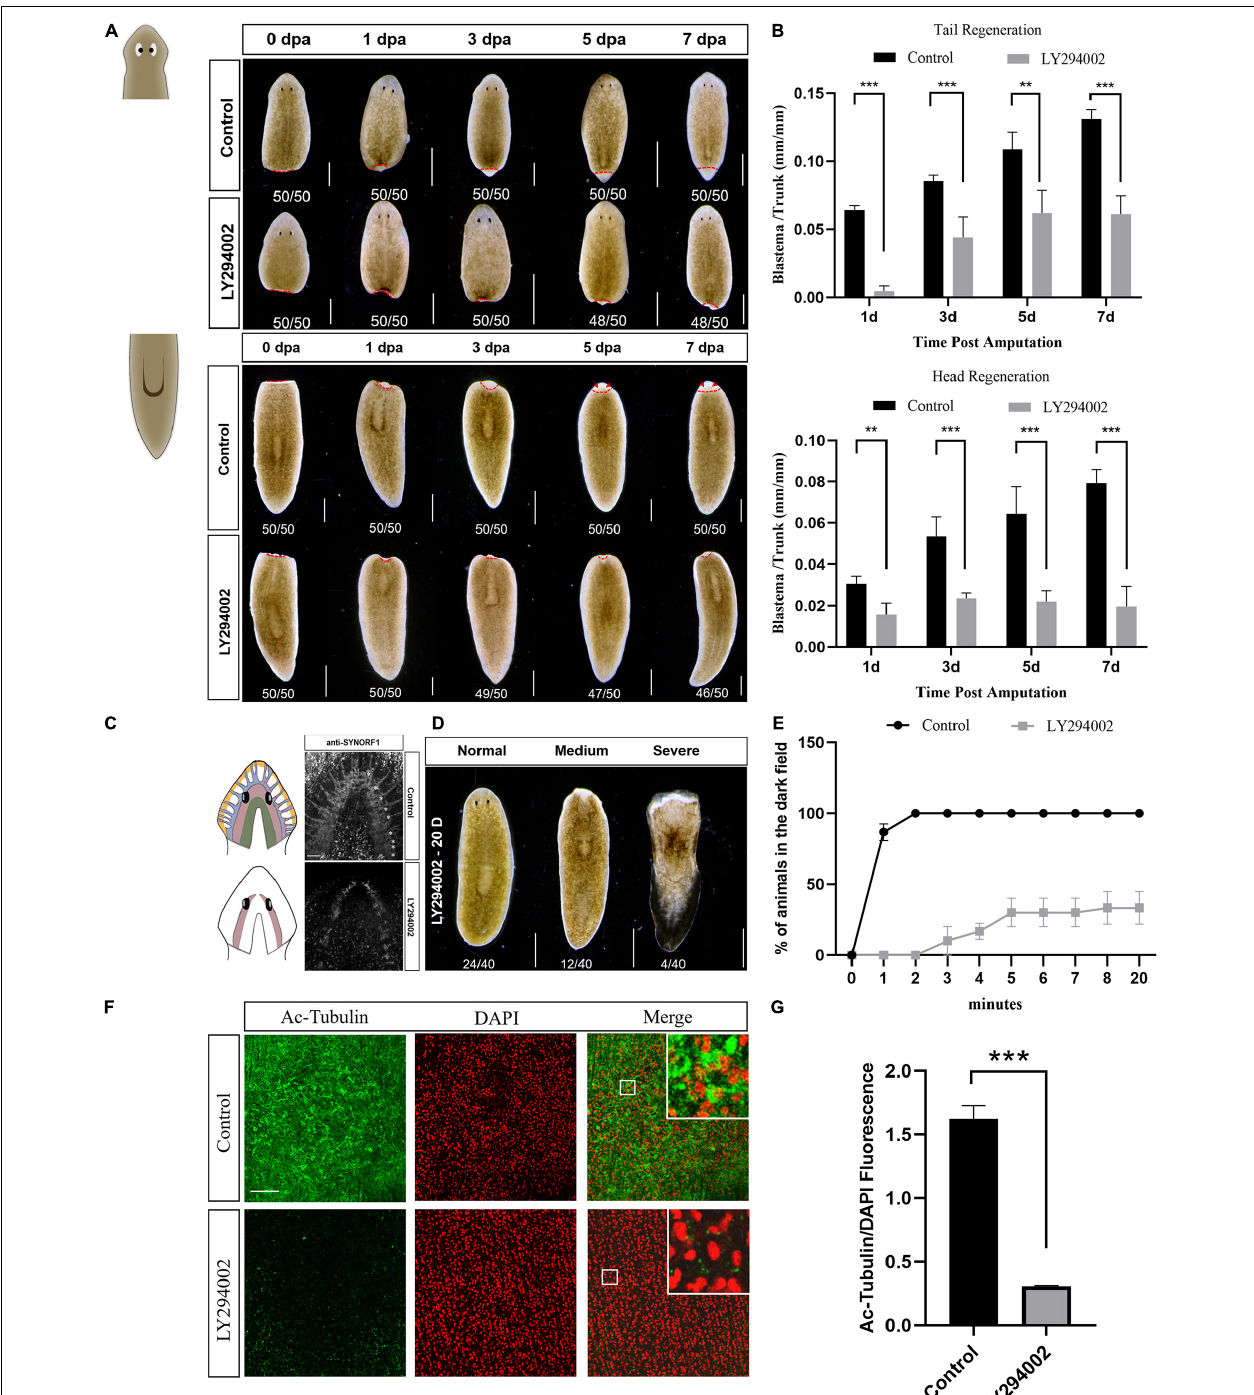
FIGURE 3 | Effect of the PI3K inhibitor LY294002 on planarian regeneration and homeostasis. (A) Dorsal images of control and LY294002-treated head and tail fragments at 0, 1, 3, 5, and 7 days post amputation. Newly-regenerated photoreceptors are indicated with red arrows. Scale bar = 1 mm. (B) Quantification analysis of blastema growth. The length of the regenerated blastema was measured and normalized to the whole-body length of the trunk. ** P < 0.01 and *** P < 0.001, by the Student’s t -test. (C) Cartoon and immunostaining of the regenerated CNS at 7 dpa using an anti-SYNORF1 antibody in control (top) and LY294002-treated animals (bottom). Lateral branch neurons are indicated with asterisks. Scale bar = 100 µ m. (D) Representative phenotypes induced by a 20-day treatment of LY294002. Scale bar = 1 mm. (E) Planarian locomotion is hampered by LY294002 treatment. Gliding ability is evaluated by calculating the proportion of planarians that reach the dark zone on the side opposite to light. (F) Immunostaining of the ventral cilia using an anti-Ac-Tubulin antibody (green). DAPI is used to label the nucleus (red). Magnified images are shown in the right corner. Scale bar = 100 µ m. (G) Quantification analysis of cilia density using the green/red fluorescence intensity ratio. *** P < 0.001, by the Student’s t